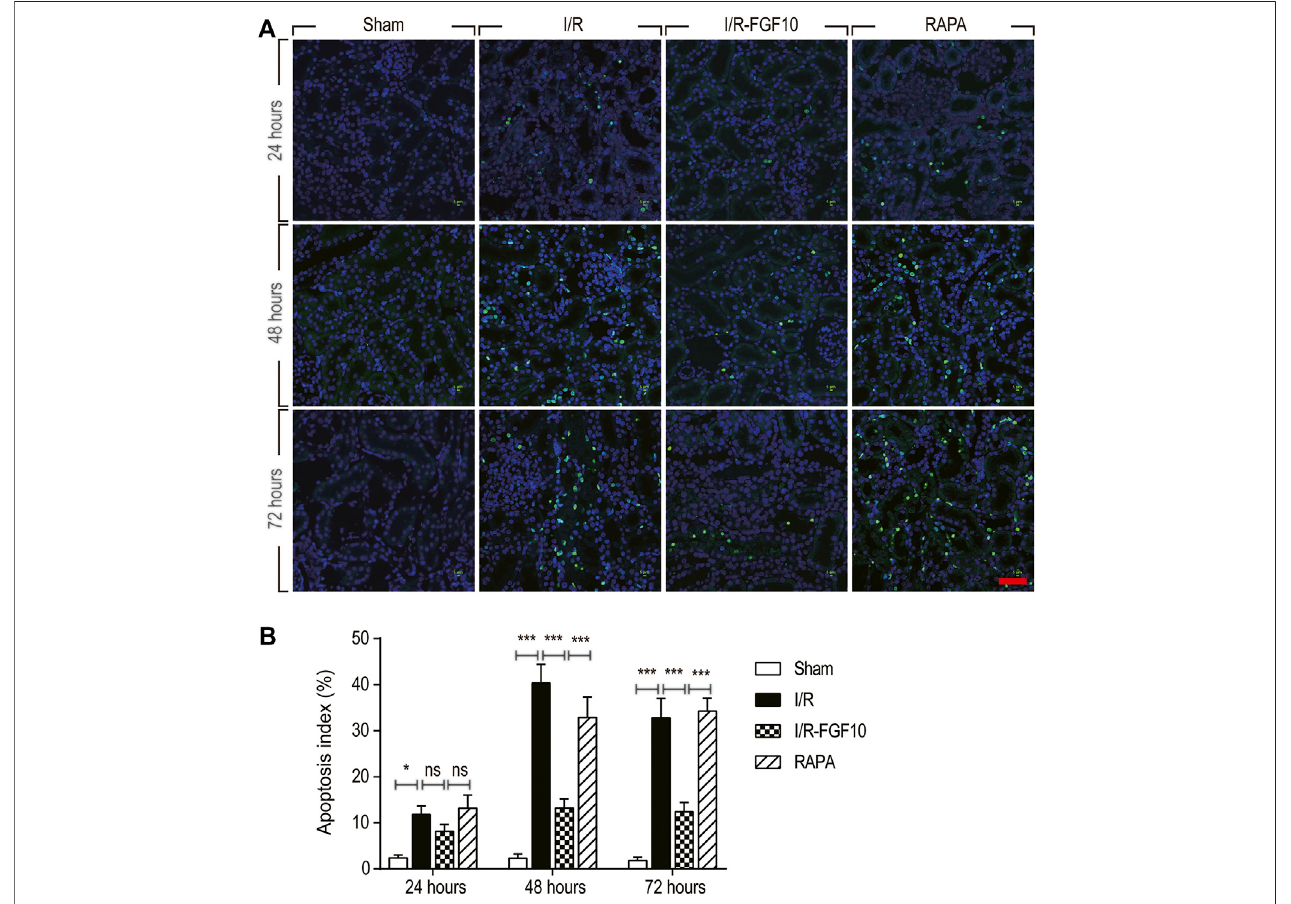
FIGURE 2 | FGF10 protects against I/R induced apoptosis in RTCs. (A) Representative sections of nuclear DNA fragmentation staining were performed using TUNELindifferentgroupsat24,48,and72 h,respectively,afterreperfusion.Scalebars (cid:1) 50 µM. (B) QuantitativeanalysisofthenumberofTUNEL-positiveRTCs.Data are presented as the mean ± SD ( n (cid:1) 5). p p < 0.05, ppp p < 0.001. The percentage of positive cells was analyzed with 5 individual magni fi cation × 400 fi elds per group.